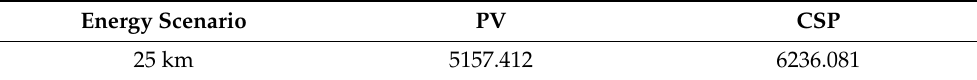
Table 5. Produced H 2 in the first pathway from PV and CSP in (kg × 10 6 ).